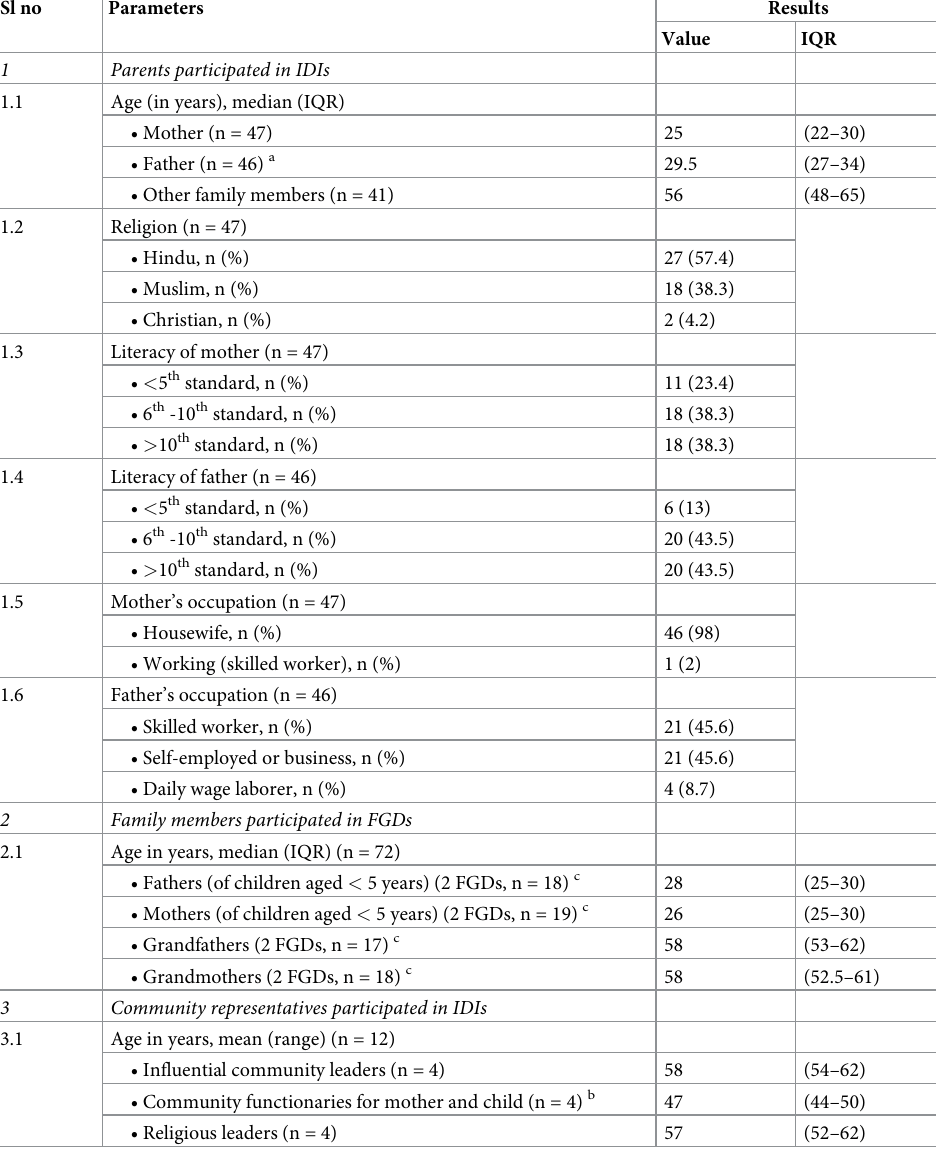
Table 1. The sociodemographic characteristics of the study